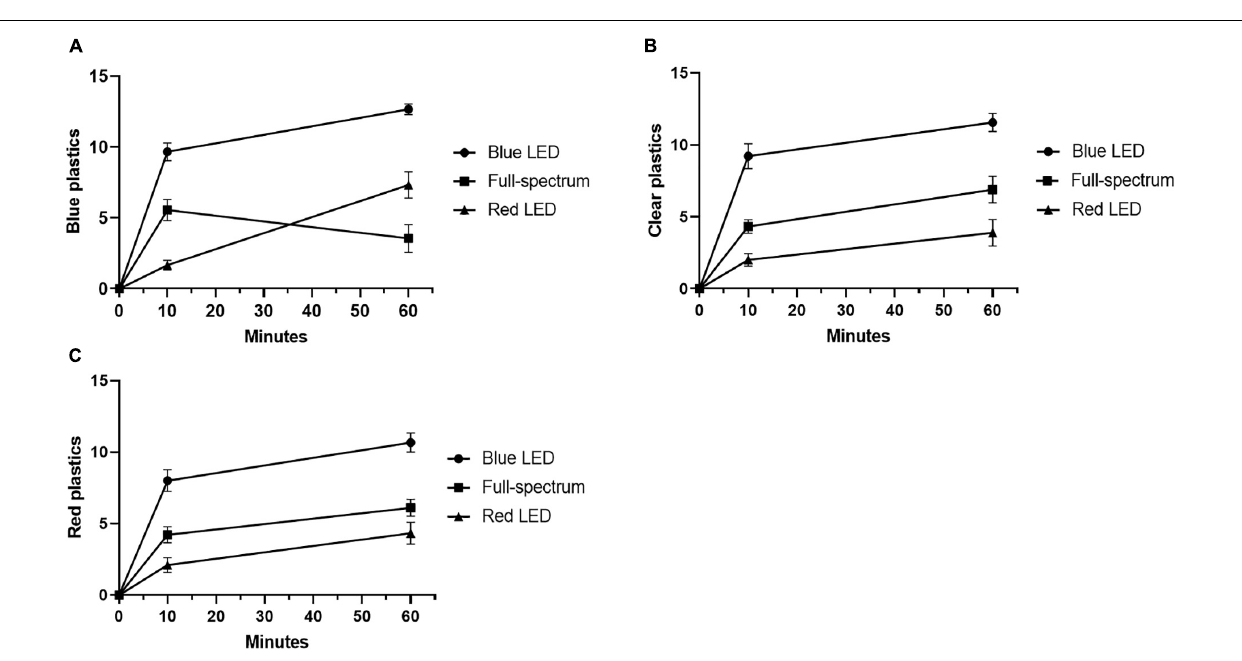
The Choice of Cover As shown in Figure 5 , the numbers of blue, red, and transparent acrylic sheets gripped by the sea urchin did not differ significantly,